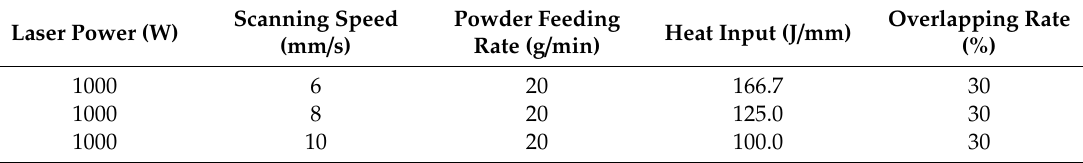
Table 2. Laser processing